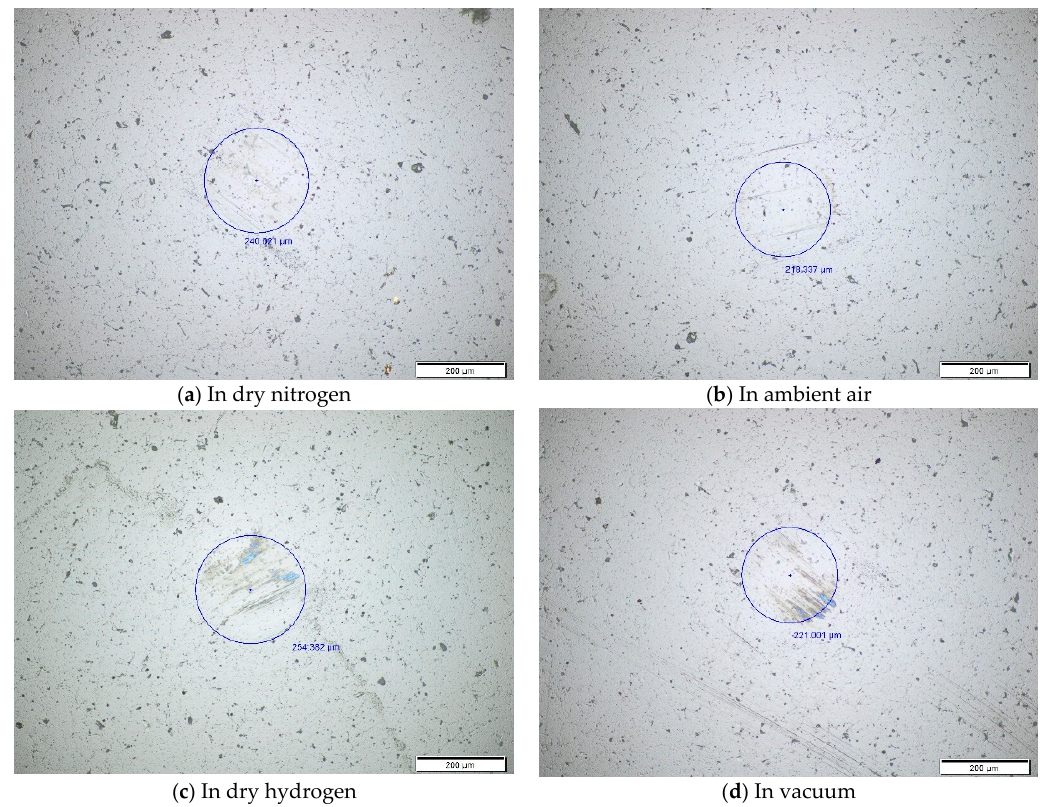
Figure 6. Worn surface images of ball under different environments at 100 °C: ( a ) in dry nitrogen, ( b ) in ambient air, ( c ) in dry hydrogen, ( d ) in vacuum and there is the worn zone within circle.